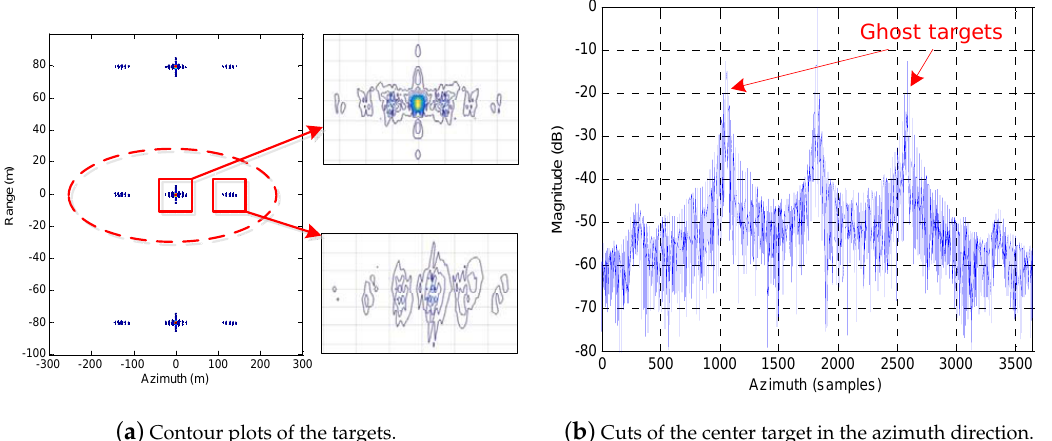
( b ) Cuts of the center target in the azimuth direction. Figure 6. The results obtained by the subaperture imaging method.